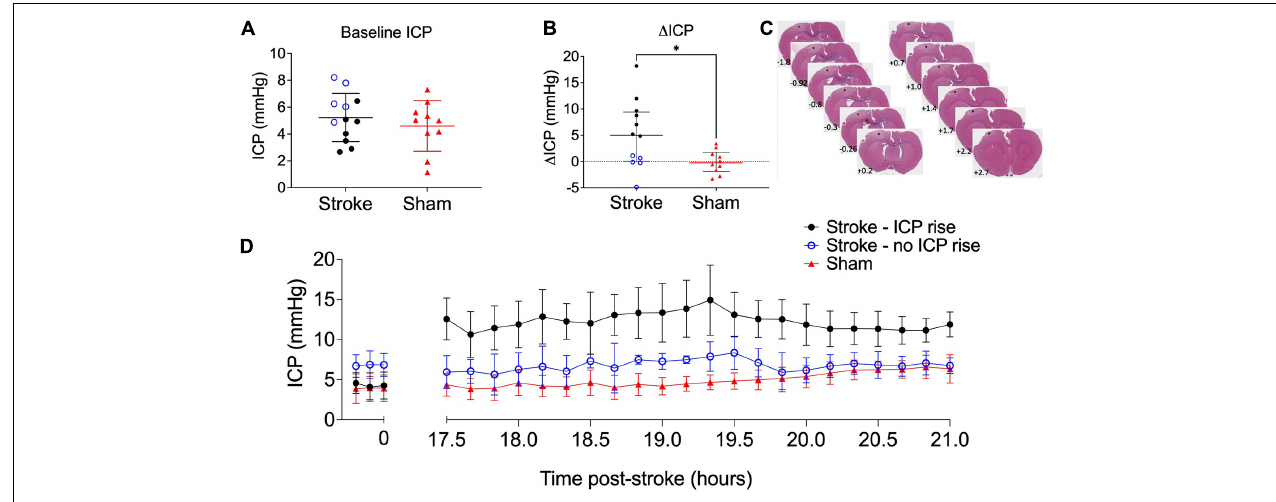
FIGURE 2 | (A) Baseline intracranial pressure (ICP; mmHg) in stroke ( n = 12; black closed circles and blue open circles) and sham ( n = 10; red triangles) rats, Student’s t -test. (B) Change in ICP from baseline to 18 h post-stroke in stroke rats and in sham rats. ∗ p ≤ 0.05, Mann-Whitney U test presented as median and interquartile range. Blue open circles indicate animals that did not have an ICP rise above +4.4 mmHg. All animals were included in statistical analysis. (C) Representative image of cortical ischaemia after H&E staining, Bregma + 2.7 to − 1.8. ∗ indicates infarct. (D) Temporal profile of mean ICP at baseline and between 17.5 and 21 h post-stroke. Nb. For all graphs stroke rats with ICP rise greater than +4.4 mmHg ( n = 5; black circles), stroke rats without ICP rise ( n = 5; blue open circles), and sham rats ( n = 7; red triangles).